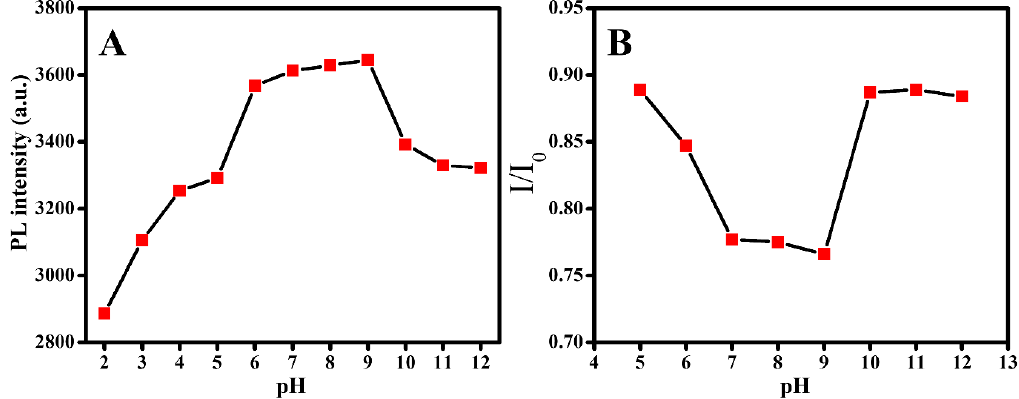
Figure 5. Fluorescence intensity of a GQDs@SMIP suspension (5 mg / mL in water) ( A ) and the quenching effect of SMZ on the fluorescence of GQDs@SMIP ( B ) at various pH values. The fluorescence intensities of GQDs@SNIP and GQDs@SMIP were quenched in the presence of